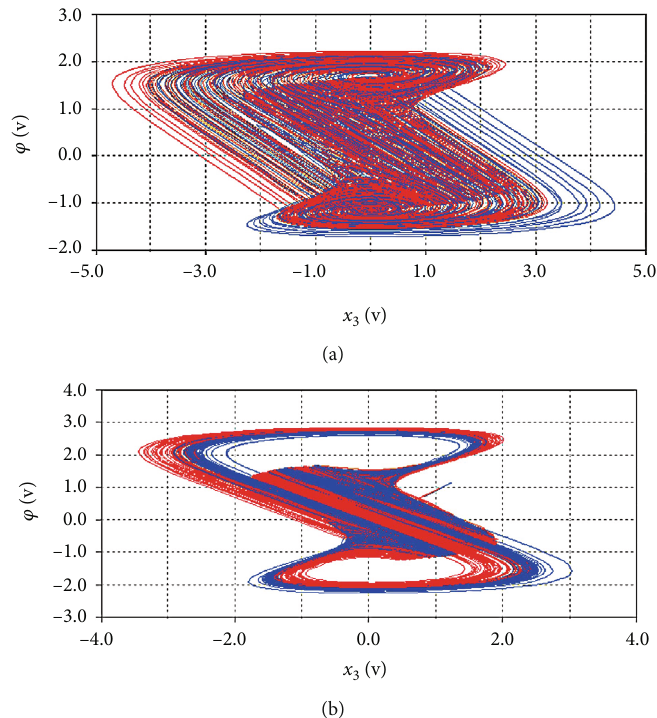
= 14 : 286k Ω and (b) R 2